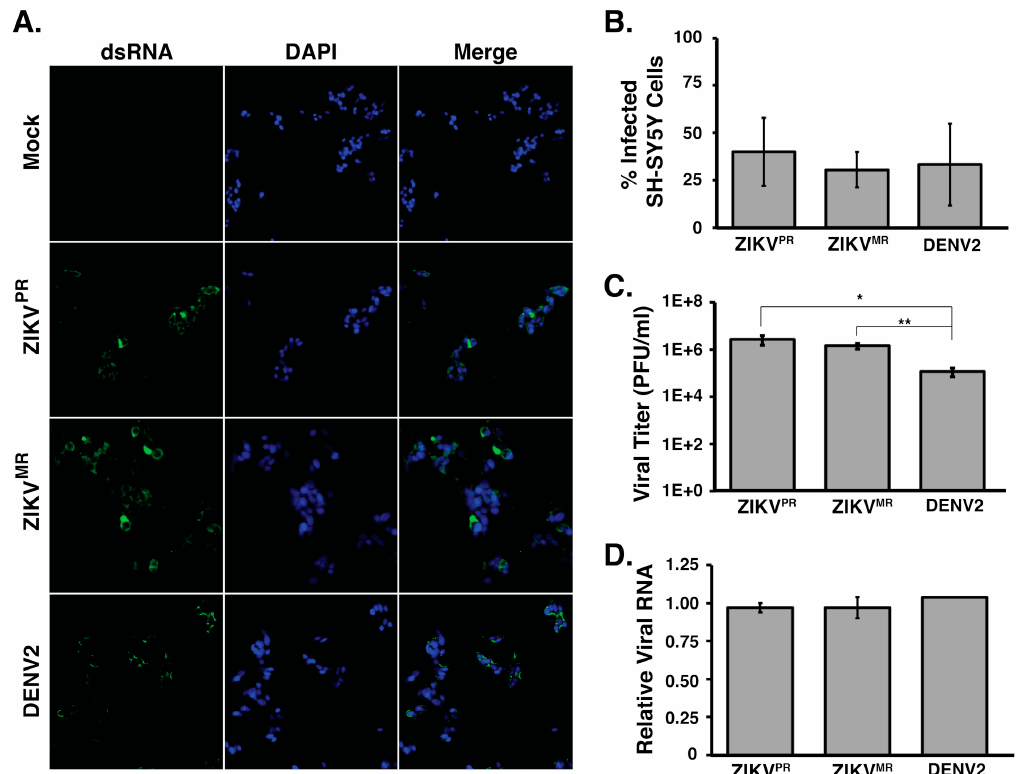
Figure 1. SH-SY5Y cells are infected by ZIKV and DENV2. ( A ) Immunofluorescence images of virus-infected SH-SY5Y cells. SH-SY5Y cells seeded in 48-well plates were infected at a moi of 5 and fixed 24 h post infection. Virus-infected cells were visualized using an antibody that detects the replication intermediate dsRNA, and all cells in the field of view were visualized by staining cell nuclei with Hoechst and at 10 × magnification. ( B ) Quantification of the percentage of infected cells. Uninfected and virus-infected SH-SY5Y cells seeded in 48-well plates were fixed and stained for dsRNA and Hoechst. A 2F0 × objective was used to image three sections per well per virus where more than 400 cells for each independent infection were counted. The percentages of infected cells were determined. At least three biological replicates were performed. ( C ) Titers of virus released into the medium from ZIKV and DENV2-infected SH-SY5Y cells were determined by plaque assays. ( D ) RT-qPCR analysis of SH-SY5Y cells infected at a moi of 5. Primers targeting the coding regions of each virus were used along with primers for β -actin mRNA. Relative viral RNA levels were calculated by standardizing relative fluorescent units at Ct for each virus against β -actin mRNA. Error bars represent standard deviations established from three independent infections. No significant difference was determined for the number of cells counted in panel 1B, or the relative abundance of viral RNA in panel 1D. For statistical analysis, two-tailed student T-tests were performed (* p < 0.05; ** p < 0.01).